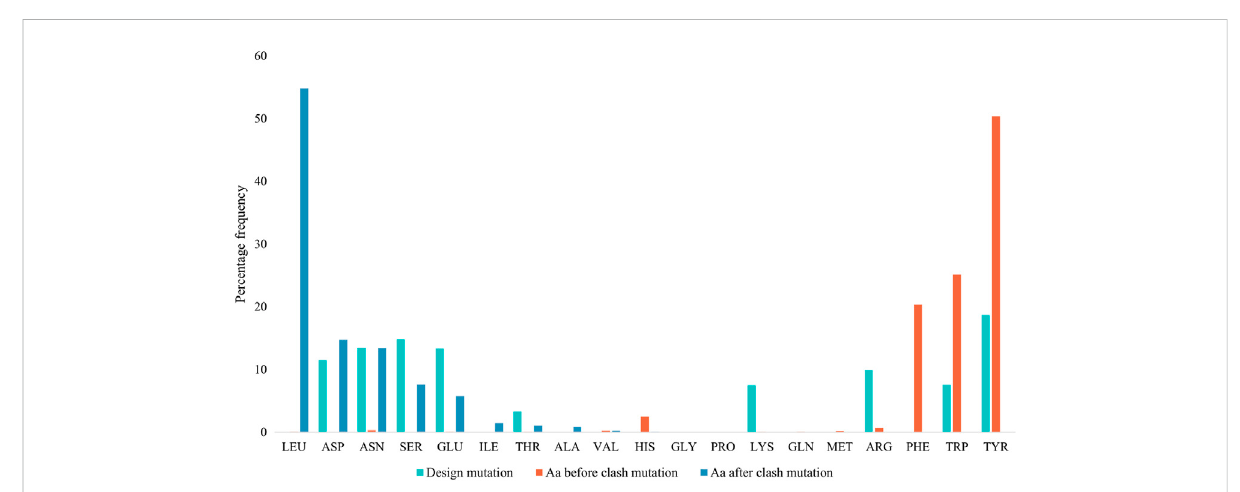
FIGURE 4 Percentage frequencies of amino acids in design mutations before and after clash mutations. In the clash mutations, aromatic amino acids which have larger side chains and lower fl exibilities were mutated to smaller polar amino acids and LEU.